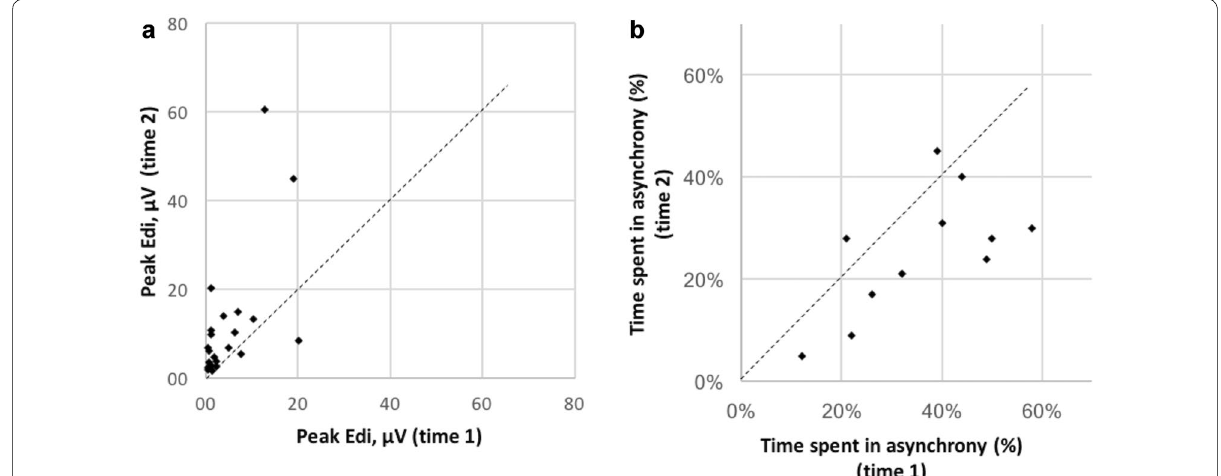
Fig. 3 Evolution of inspiratory Edi (panel a) and of the time spent in asynchrony (panel b) from inclusion time (time 1) to pre‑extubation period (time